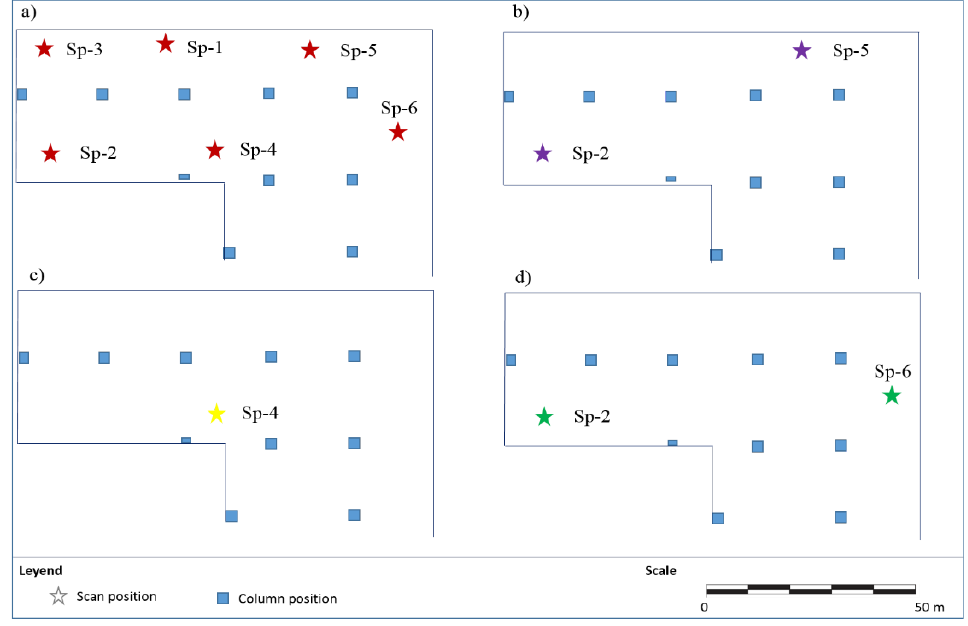
Figure 7. A schema of the datasets considered in the indoor garage case study for testing the methodology under different levels of data completeness: complete dataset ( a ), two scan positions placed at different sides of the building ( b ), one isolated scan position ( c ), and two scan positions placed at the same side of the building ( d